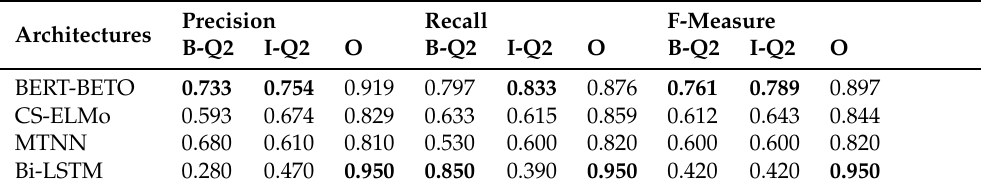
Table 2. Results for question Q2: What is the purpose of doing it?